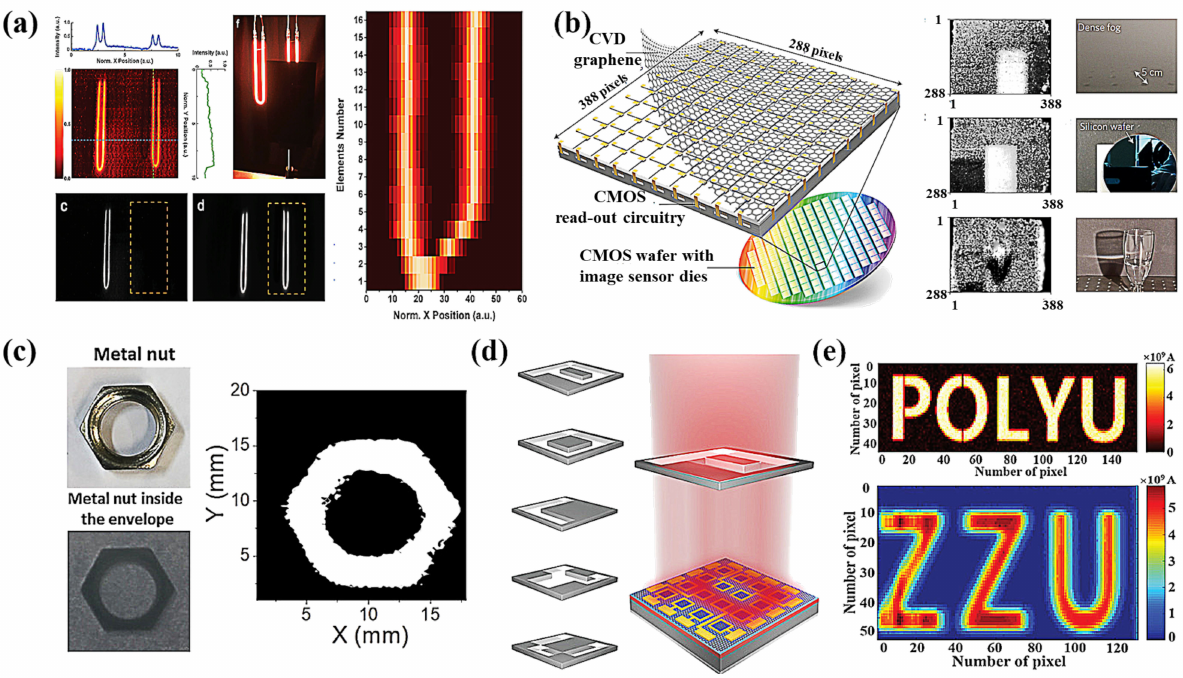
Figure 14. ( a ) Image realized from an advanced dual-band vertical heterostructure GaSe/GaSb linear array photodetec- tor. ( b ) Left: image sensor array based on graphene-complementary metal-oxide–semiconductors (CMOS) integration; right: near-infrared (NIR) and short-wave infrared (SWIR) image of a rectangular block covered in fog, behind a silicon wafer, and a glass of water. ( c ) 2D scanning imaging of the concealed metallic nut in an envelope. ( d ) Left: schematic illustration of the experimental setup for the integrated device to record infrared light imaging sensing. ( e ) The resulting images of “POLYU” and “ZZU” under 4.55 and 10.6 µ m illumination, respectively. ( a ) Reproduced with permission from [165]. Copyright Wiley, 2017. ( b ) Reproduced with permission from [166]. Copyright Nature Publishing Group,